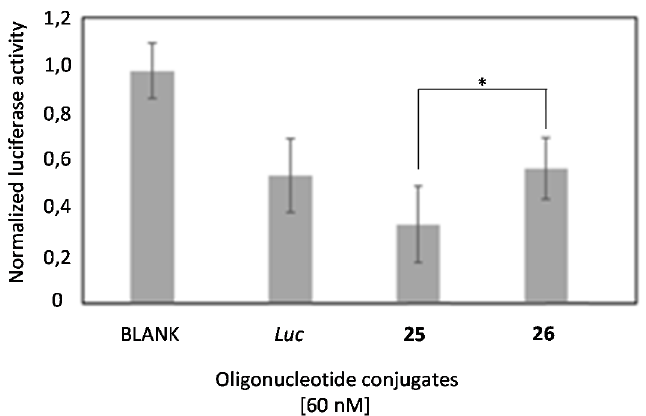
Figure 10. Gene transfection studies targeting Renilla luciferase mRNA in the presence of Lipofec-